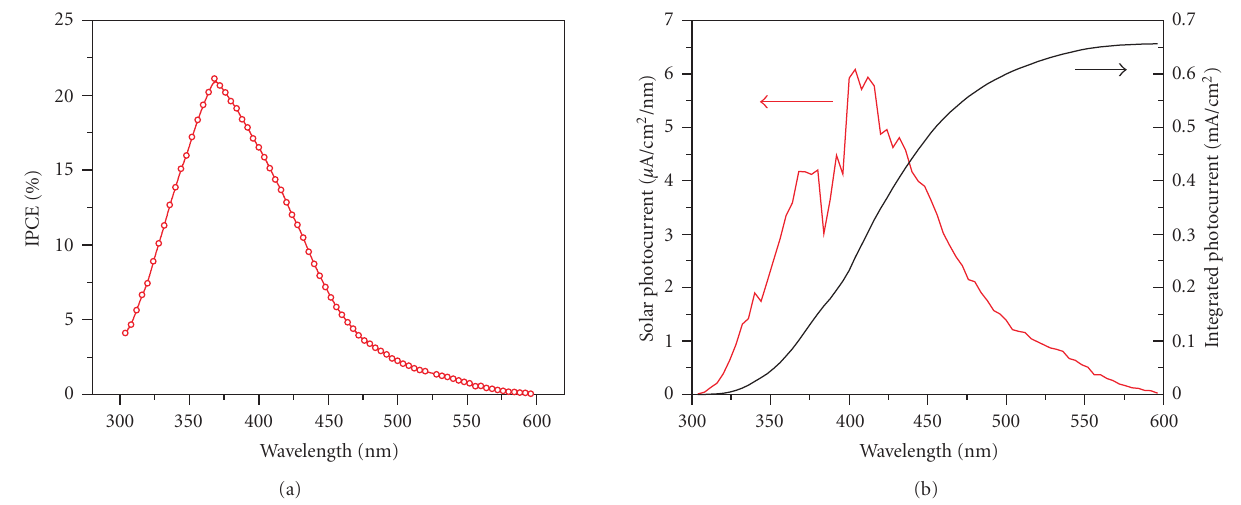
Figure 4: (a) IPCE curve for 0.1% Si-doped Fe 2 O 3 measured at 0.4 V versus Ag/AgCl. (b) Momentary and integrated solar photocurrent of the sample obtained by multiplying IPCE with the photon flux spectrum of AM1.5 sunlight. When correcting for the actual experimental intensity of 80 mW/cm 2 , an integrated photocurrent of 0 . 8 × 0 . 66 = 0 . 53 mA/cm 2 is